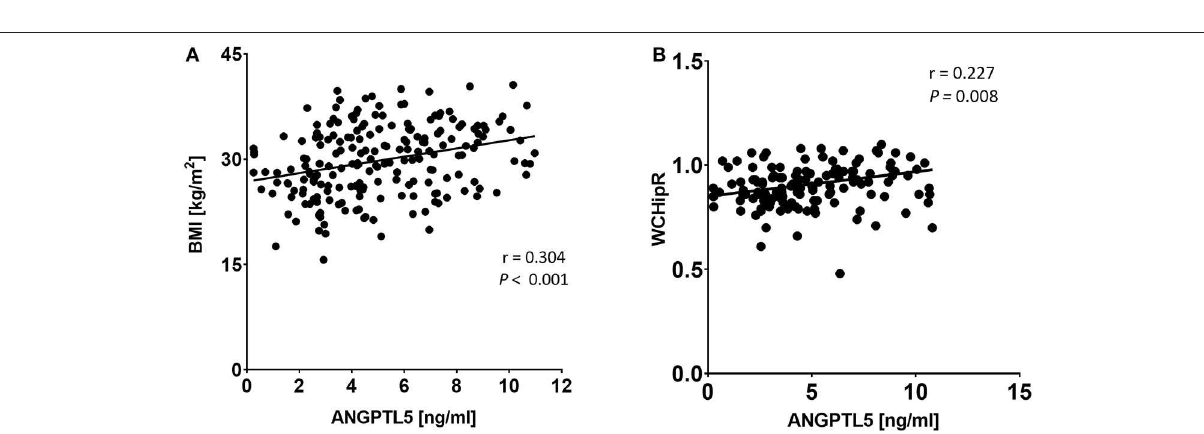
had been shown to positively correlate with body fat (28). In fact, T2D, improve insulin sensitivity and glucose homeostasis